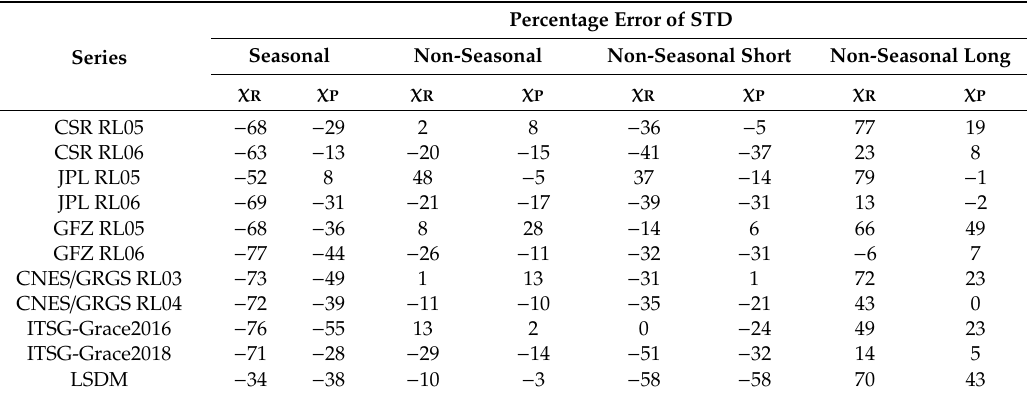
Table 1. Percentage error of standard deviation (STD) of hydrological angular momentum (HAM) computed from Gravity Recovery and Climate Experiment (GRACE) solutions and HAM from the land surface discharge model (LSDM). ITSG, Institute of Theoretical Geodesy and Satellite Geodesy; GFZ,